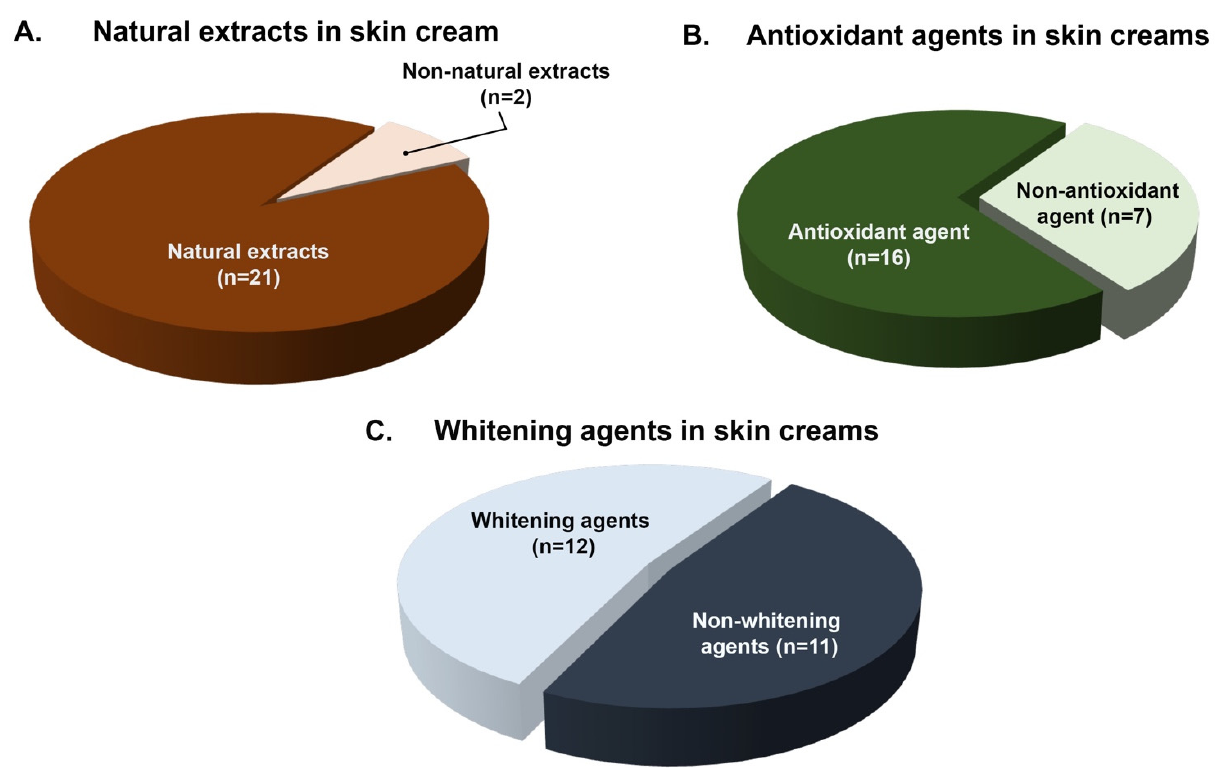
Figure 1. The characteristics of the studied cosmetic cream products from Thai market (Total number of samples = 23).